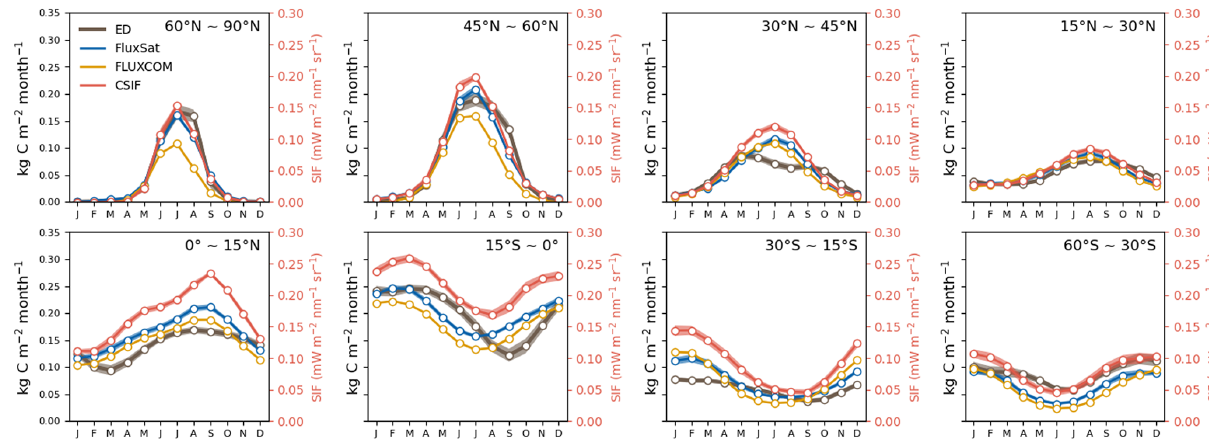
Figure 8. Average seasonal cycle (2001–2016) of GPP (from ED, FLUXCOM and FluxSat) and CSIF by latitudinal band.